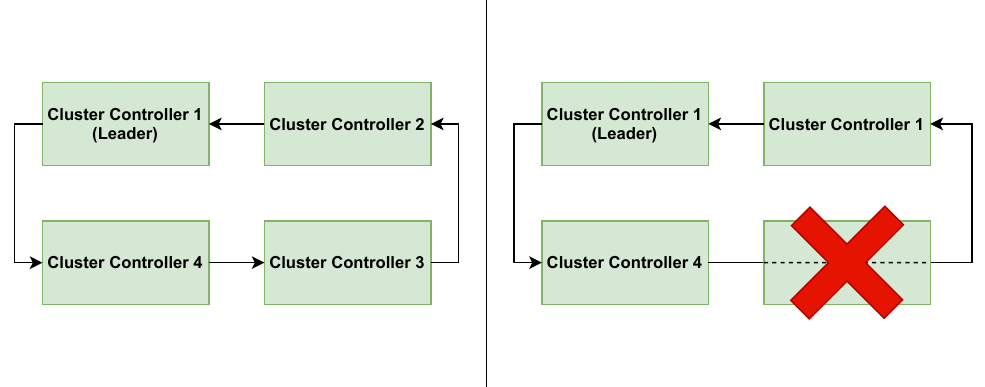
Figure 3. The cluster controller is replicated and connected in a